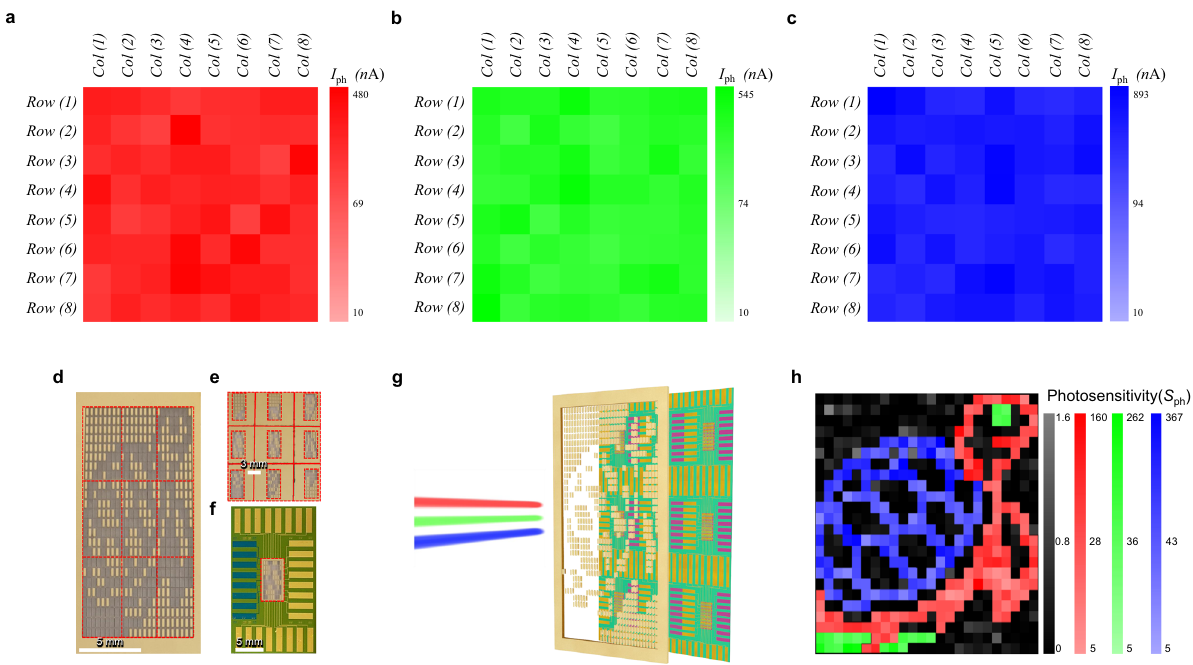
Fig. 7 Image-sensing characteristics of 8 × 8 bilayer MoS 2 image sensor array. a – c Photocurrent mapping of 64 MoS 2 phototransistors at V ds = 1 V, V gs = − 10 V under RGB light illumination ( λ = 638, 532, and 405 nm and P = 3.2 mW cm − 2 ), indicating uniform photocurrent photoresponses. d ex inc Photograph of the designed turtle stencil for projection (total 24 × 24 pixels). e Separated turtle stencils for individual light stencil projection on 8 × 8 image sensor array. f Top view of the image sensor array covered with a piece of separated turtle stencils. g Measurement concept using the light stencil projection for image detection of the image sensor array. The 8 × 8 bilayer MoS 2 image sensor array is placed behind turtle stencil and measured electrical properties under RGB light illumination ( λ ex = 638, 532, and 405 nm). h Photosensitivity mapping result extracted from image detection of bilayer MoS 2 image sensor